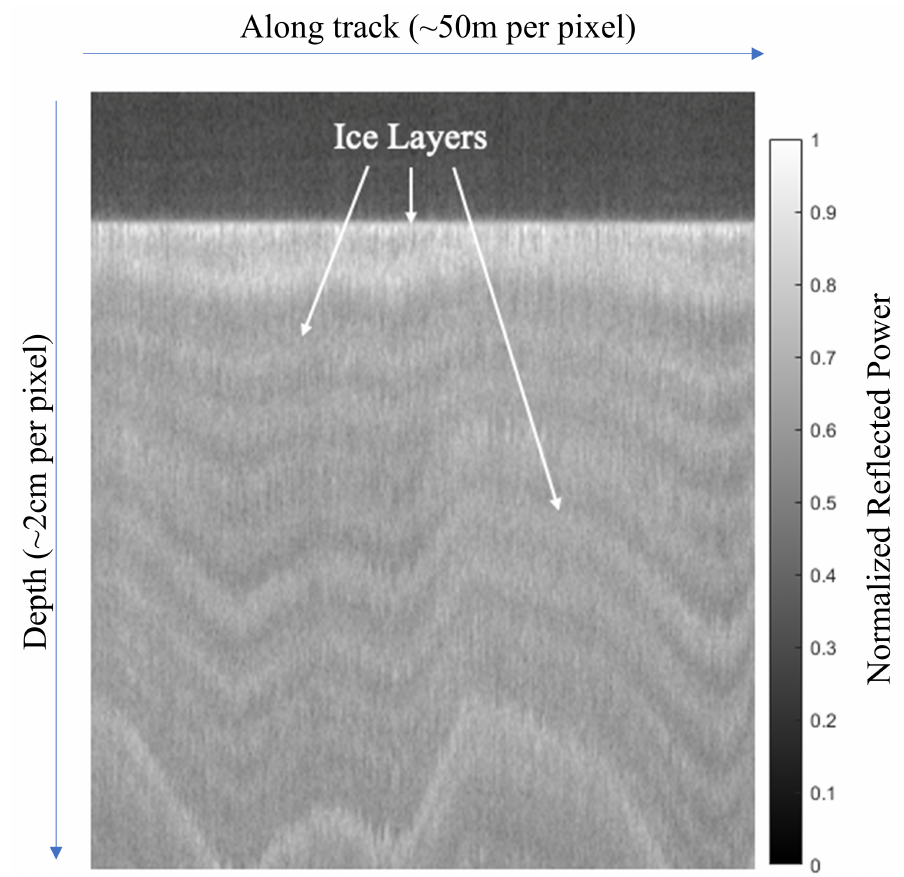
Figure 1. A Snow Radar echogram showing multiple internal layers of